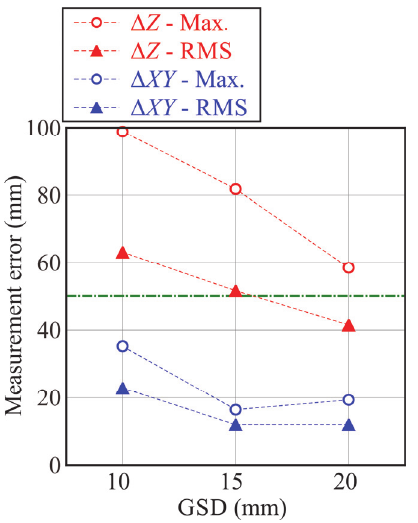
Figure 14. Measurement errors of 9 check points by Phantom 4 vs. GSD